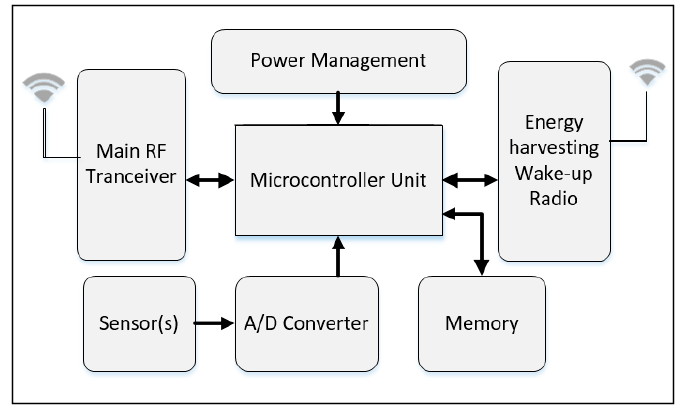
Figure 1. Sensor node with passive wake-up radio.